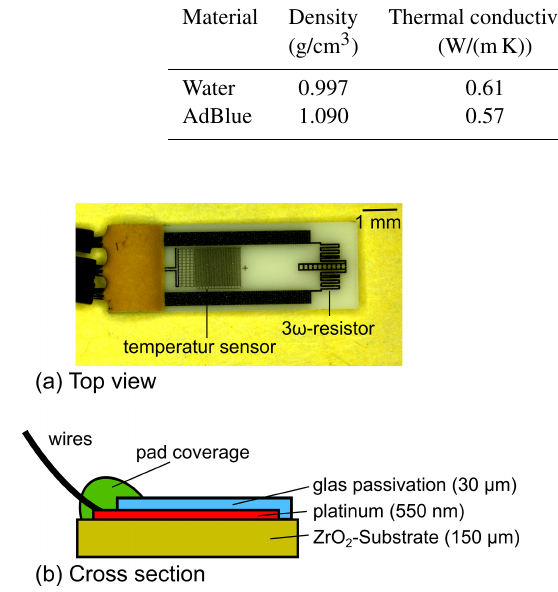
Figure 1. (a) Top view of the sensor; two platinum thin-film struc- tures are on the investigated chip. First, a low-resistance structure which is called a 3 ω resistor in this investigation acting as the heater and as the sensor if the 3 ω method is applied. Second, a high- resistance structure is on the chip which can be used as an addi- tional temperature sensor. (b) Cross section of the sensor consists of a platinum thin-film layer with a thickness of 550nm which is applied on a 150µm zirconium oxide substrate. A 30µm thick glass passivation is on top of the platinum layer to protect the platinum structure.